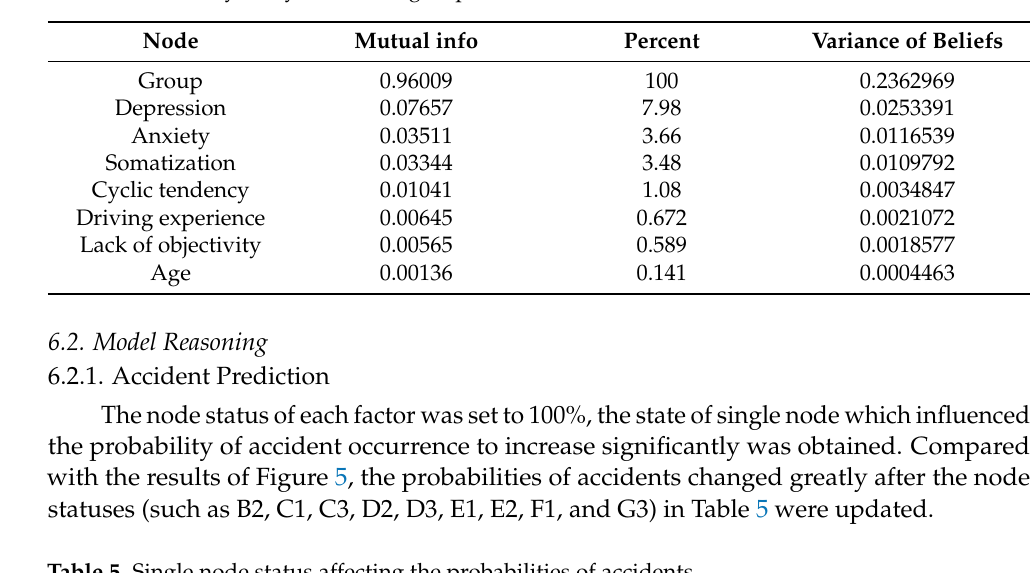
Table 4. Sensitivity analysis of node groups.